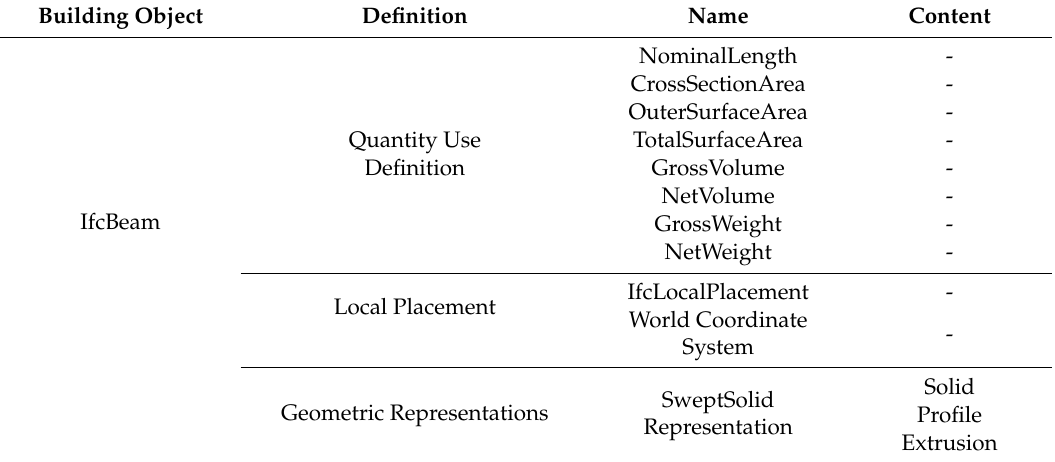
Table 6. Data structure of IfcBeam